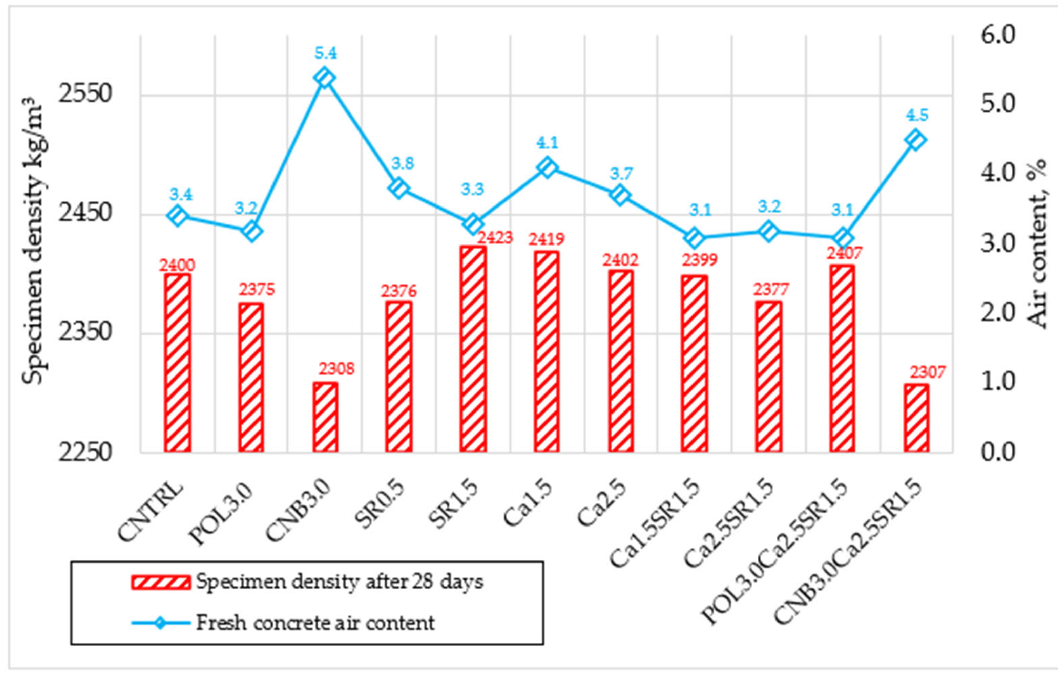
Figure 5. Relationship between specimen density after 28 days and air content.